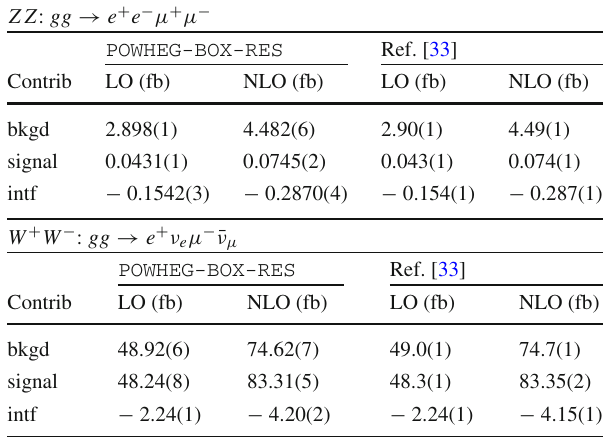
Table1 ComparisonofLOandNLOcrosssectionsforthesignal,back- ground, and interference contributions to gg → Z Z → e + e − μ + μ